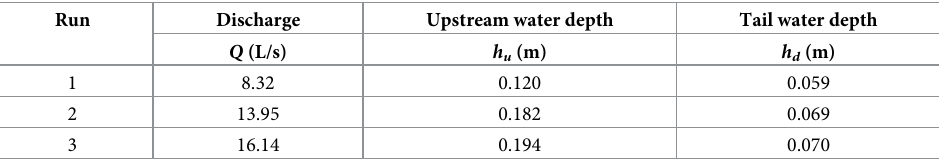
Table 1. Operating